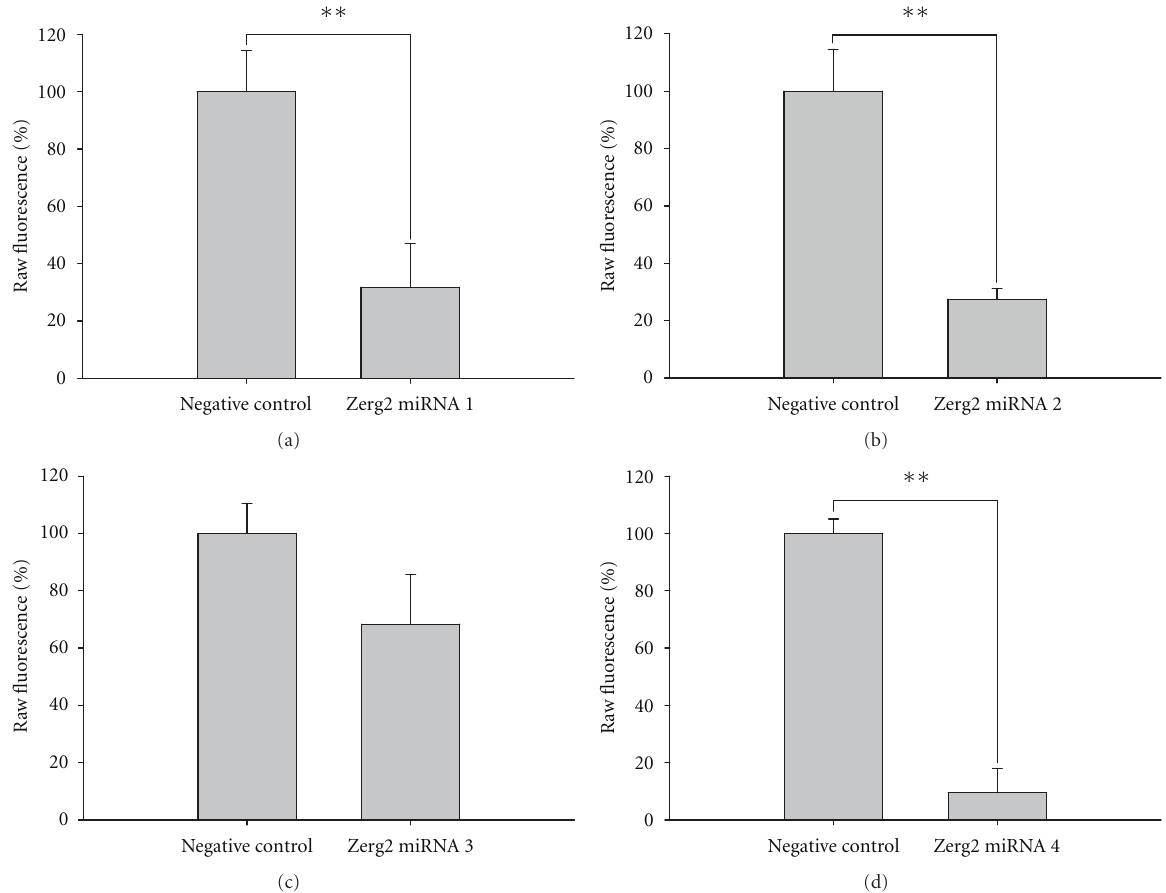
Figure 2: In vivo eGFP sensor assay for zerg-2 miRNAs. (a) zerg-2 miRNA 1 with eGFP knockdown at approximately 69%. (b) zerg-2 miRNA 2 with eGFP knockdown at approximately 73%. (c) zerg-2 miRNA 3 with eGFP knockdown at approximately 32% (the results are not statically significant). (d) zerg-2 miRNA 4 with eGFP knockdown at approximately 88%. ∗∗ P < 0 . 01. All statistical analysis was carried out using one-way ANOVA. The percentage of fluorescence emitted by the injected embryos was determined by comparison to negative control embryos (those injected with scrambled